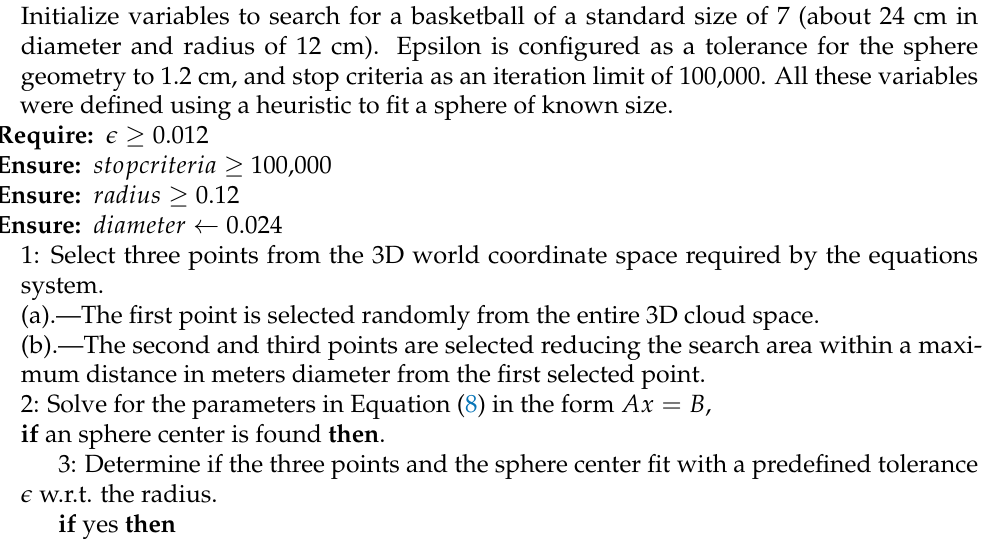
Algorithm 1 Fit sphere with a known size using RANSAC in a 3D cloudpoint. Initialize variables to search for a basketball of a standard size of 7 (about 24 cm in diameter and radius of 12 cm). Epsilon is configured as a tolerance for the sphere geometry to 1.2 cm, and stop criteria as an iteration limit of 100,000. All these variables were defined using a heuristic to fit a sphere of known